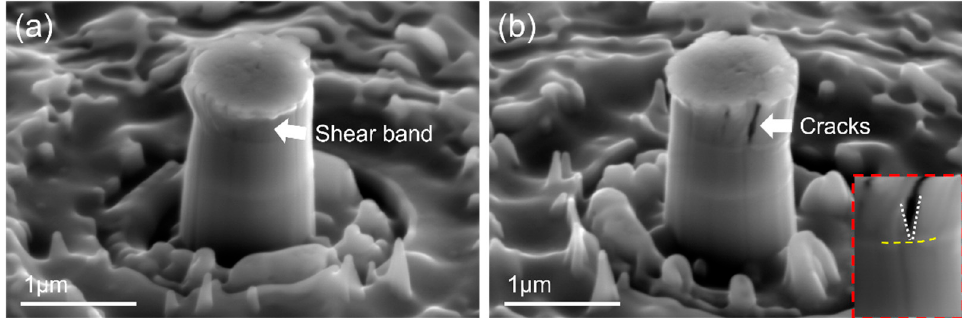
Figure 5. Postmortem SEM ( a ) front view; ( b ) side view of deformed NL HEA/graphene micropillar.